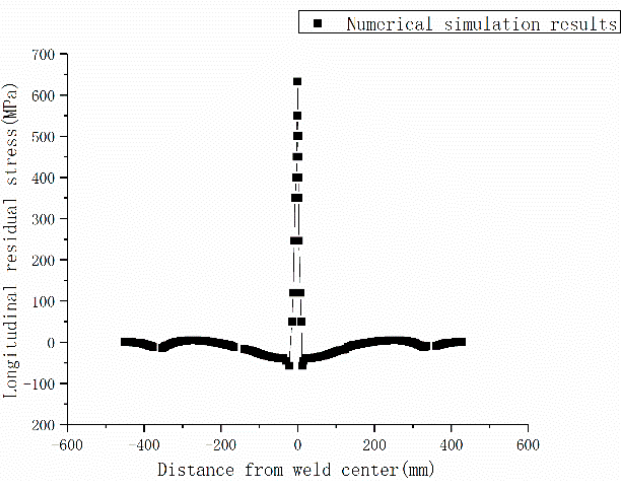
Figure 20. Longitudinal residual stress along the vertical weld path on the inner surface of the spherical pressure hull.